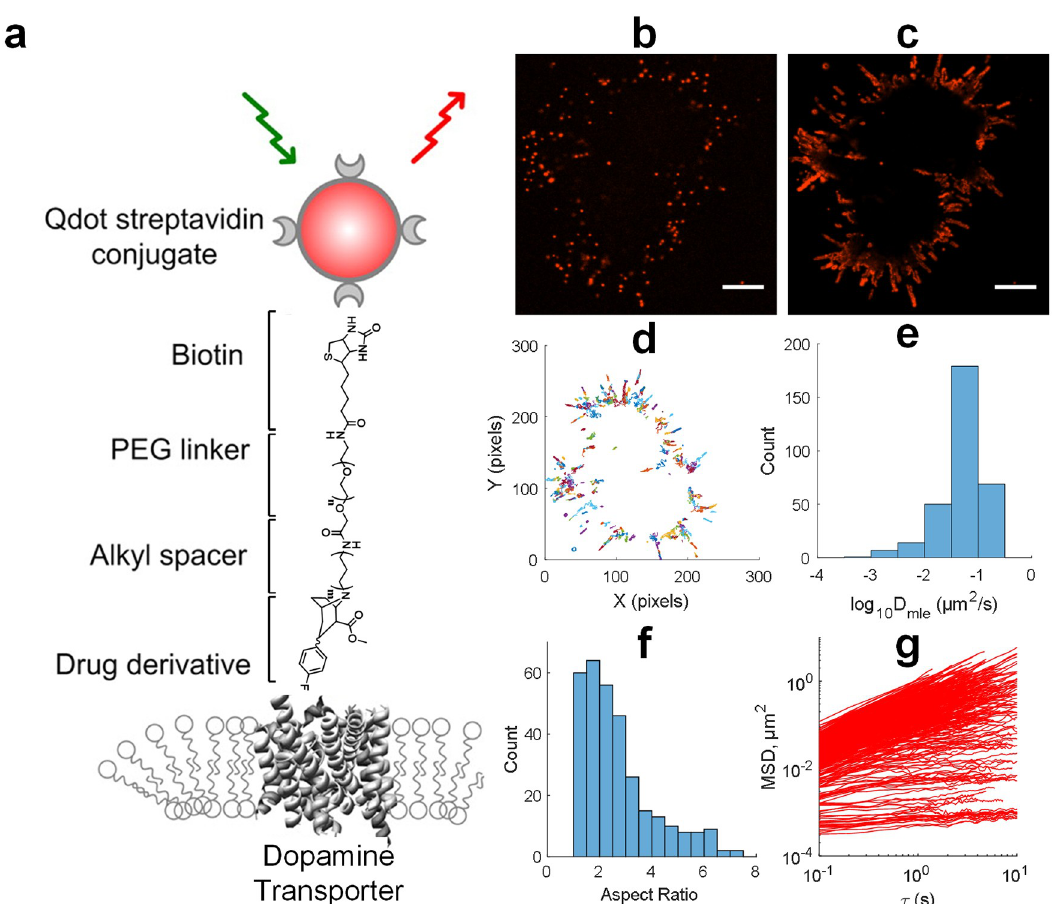
Fig 1. Single Qdot tracking reveals DAT heterogeneous diffusion dynamics. (a) The schematic illustrates the DAT-Qdot targeting strategy that relies on the use of biotinylated IDT444 ligand [20]. (b) A single frame of DAT-Qdot distribution at the basolateral membrane of HEK-293 cells; the image is representative of more than 5 independent experiments. Scale bar: 10 μ m. (c) A maximum intensity projection of a 60-s time-lapse sequence of DAT-Qdots shown in b acquired at 10 Hz. Scale bar: 10 μ m. (d) Reconstructed trajectories depicting DAT-Qdot motion in c. (e) A histogram of a diffusion coefficients D MLE corresponding to trajectories in d. (f) A histogram of aspect ratios corresponding to individual trajectories in d. (g) A plot of individual MSD over time curves corresponding to individual trajectories in d and illustrating DAT-Qdot heterogeneous diffusion dynamics at the surface of a single cell examined.